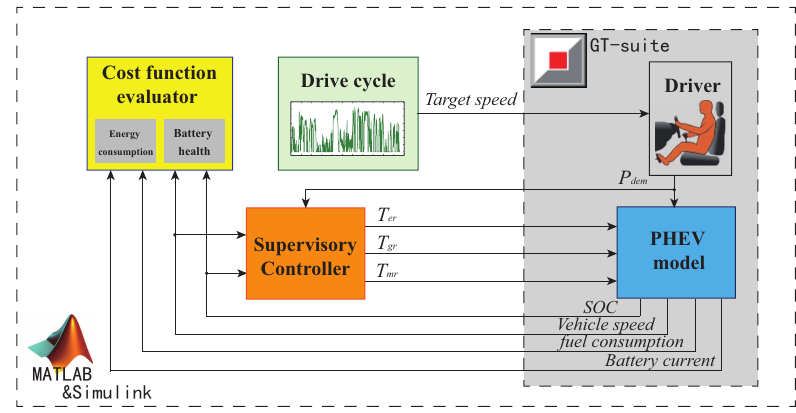
Figure 8. Schematic of PHEV with supervisory controller in the